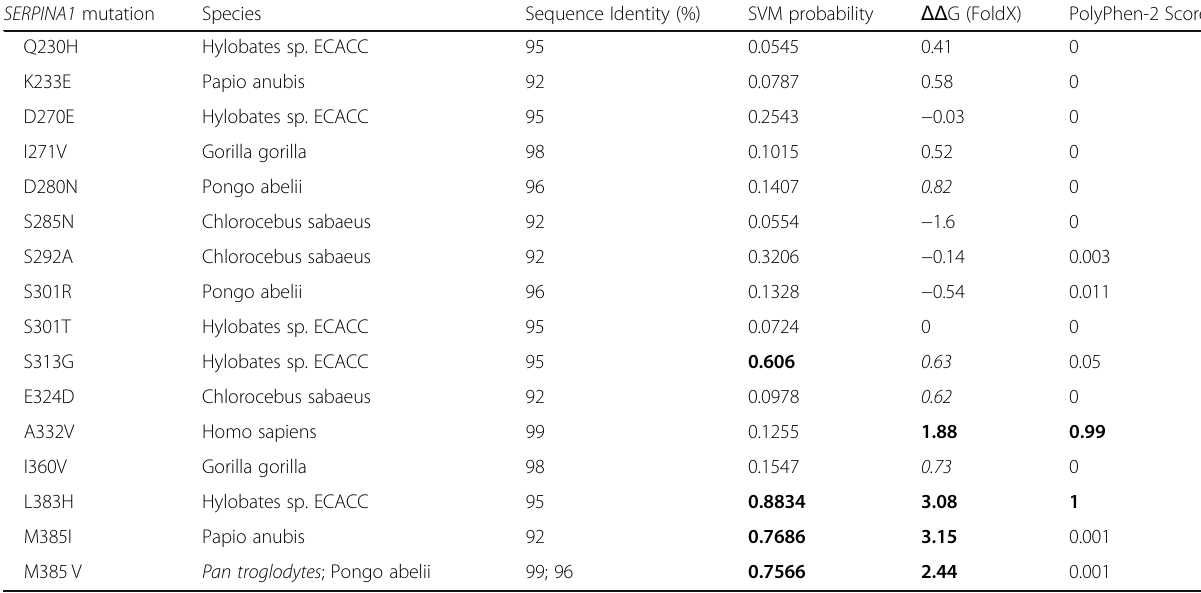
Table 3 Results of benchmarking analysis (Continued) SERPINA1